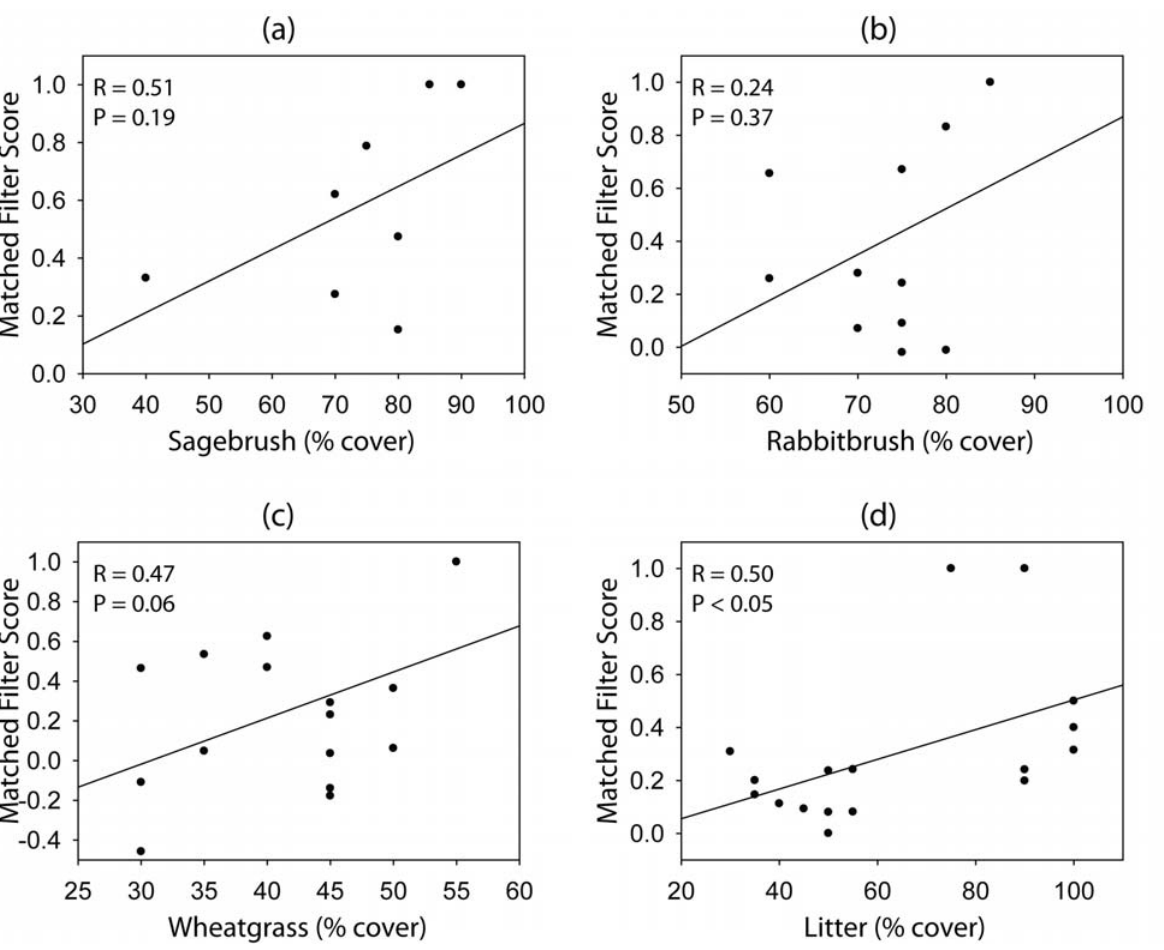
Figure 7. The relationships between the matched filter scores and the percent cover of the vegetation species for the Monticello site: ( a ) sagebrush, ( b ) rabbitbrush, ( c ) wheatgrass, and ( d )